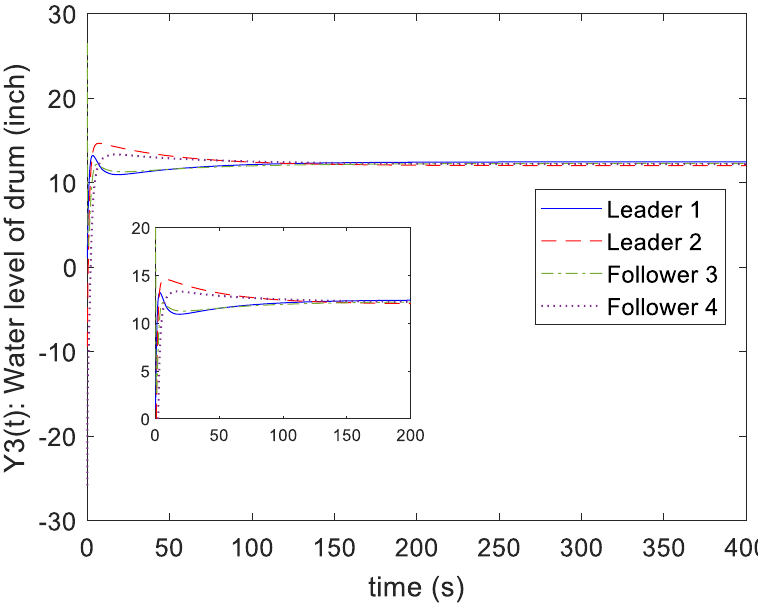
  Y t with type-1 robust fuzzy control. 3